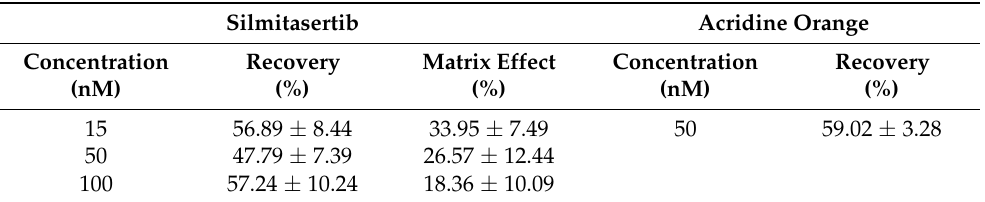
Table 2. Matrix effect and recovery of silmitasertib and the internal standard acridine orange. Values are mean percentages ± standard deviation (SD) of n = 5 (except for the recovery of silmitasertib, n = 4). Silmitasertib Acridine Orange Concentration Recovery Matrix Effect Concentration Recovery (nM) (%) (%) (nM) (%) 15 56.89 ± 8.44 33.95 ± 7.49 50 59.02 ± 3.28 50 47.79 ± 7.39 26.57 ± 12.44 100 57.24 ± 10.24 18.36 ±